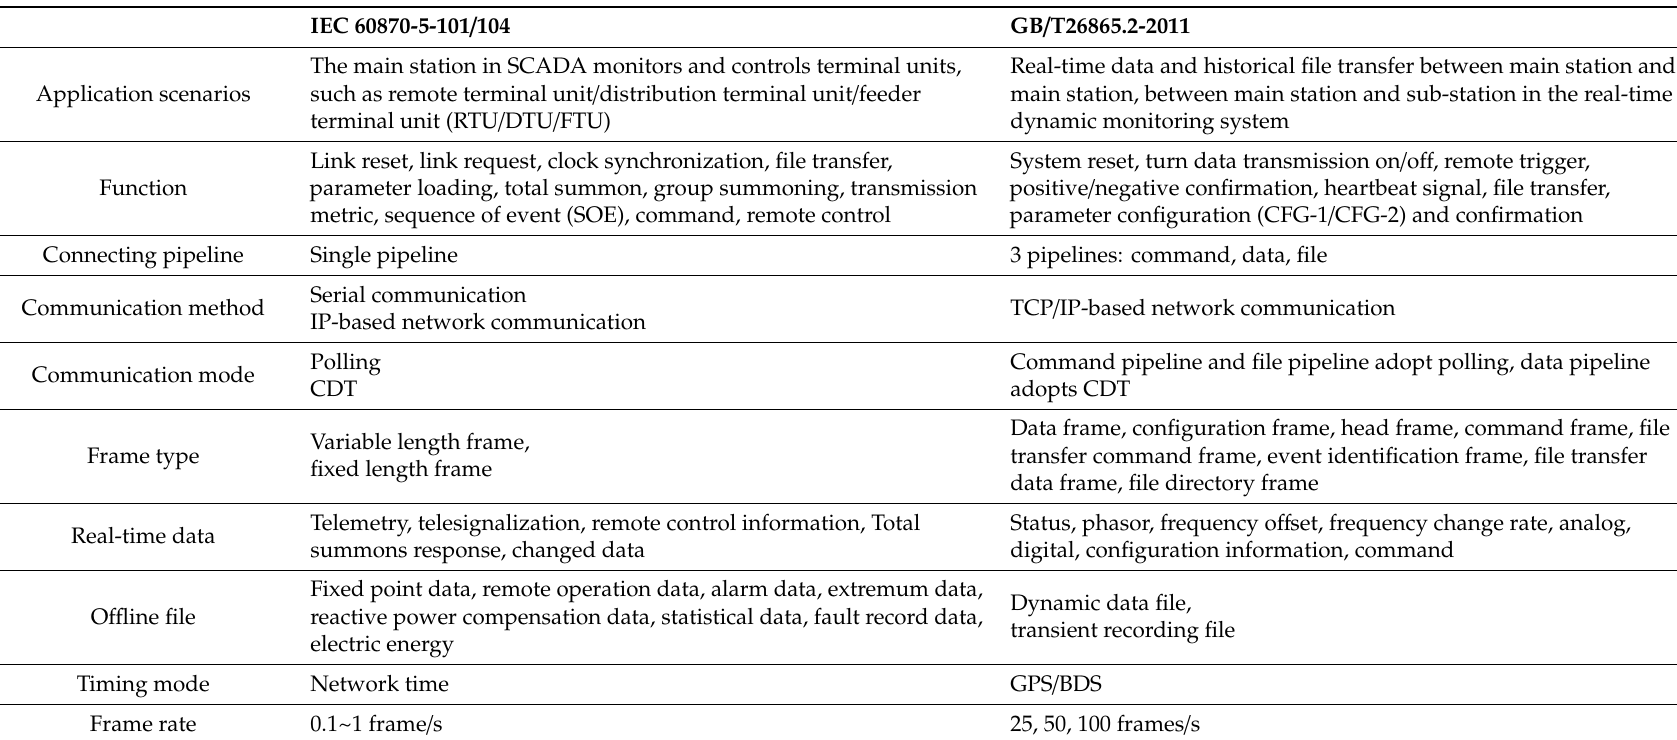
Table 3. Comparison of